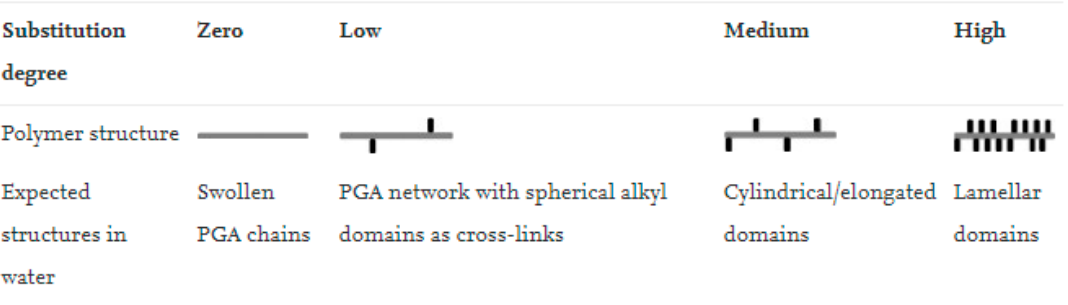
Table 1. Influence of substitution degree on polymer aggregation [33]. Here, the e ff ect of substitution degree on the aggregation of the polymer in water and the nature of the resulting colloidal system is summarized. Copyright 2012 Elsevier.